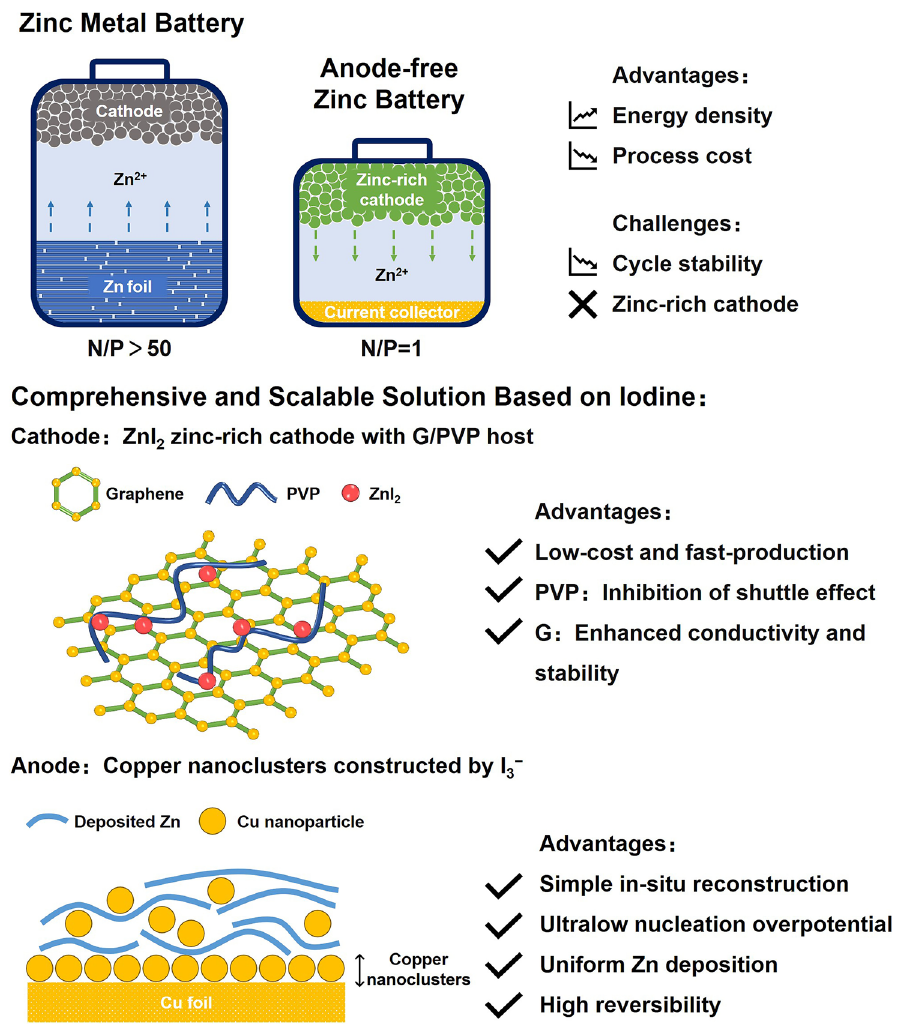
Fig. 1 Advantages and challenges for anode-free Zn metal batteries and the comprehensive solution based on iodine proposed in this